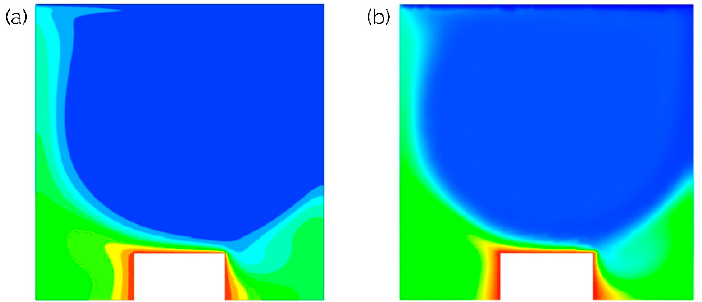
Figure 5. Contours of temperature at Re = 500, Ra = 10 5 for Al 2 O 3 -water nanofluid: ( a ) Cong et al. [6] and ( b ) result from the current model with the same configuration of Cong et al. [6].